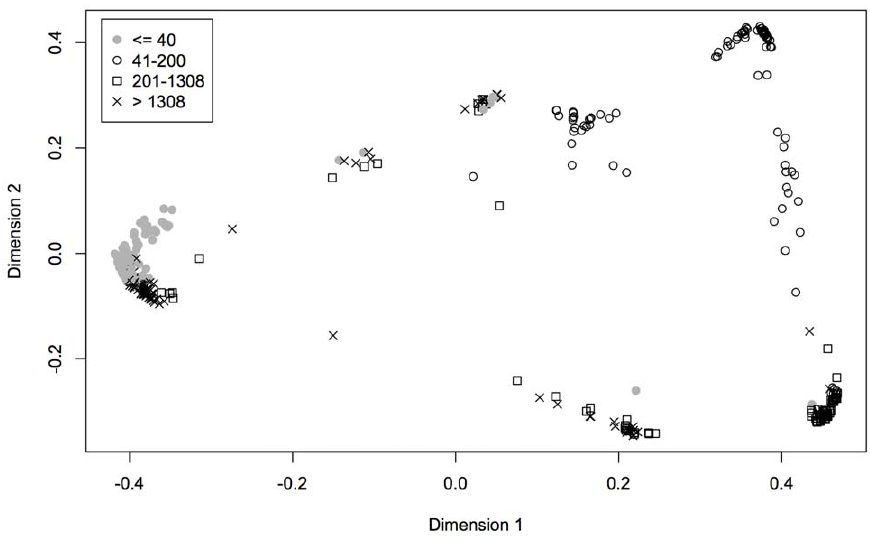
Figure 3. Grouping by number of individuals at plan writing. Multidimensional scaling plot visualizing in two dimensions a matrix of proximity scores from the random forest analysis examining whether listed plant species can be grouped by individual-based abundances only (n=352). Proximity scores are the frequencies that two observations are placed in the same terminal node, and are a measure of similarity between species. Different symbols represent the four quartiles of the number of individuals at the time of plan writing (1 st quartile: # 40 individuals, 2 nd quartile: 41–200 individuals, 3 rd quartile: 201–1308 individuals, 4 th quartile: . 1308 individuals).